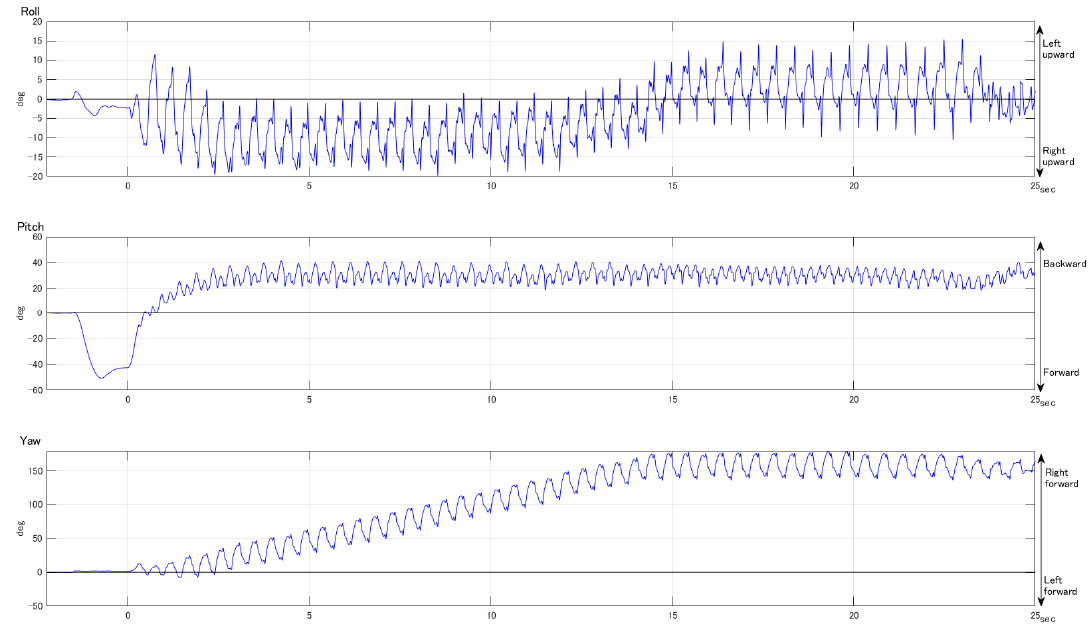
Figure 3. Representative sample of pelvic tilts transition for 200 m